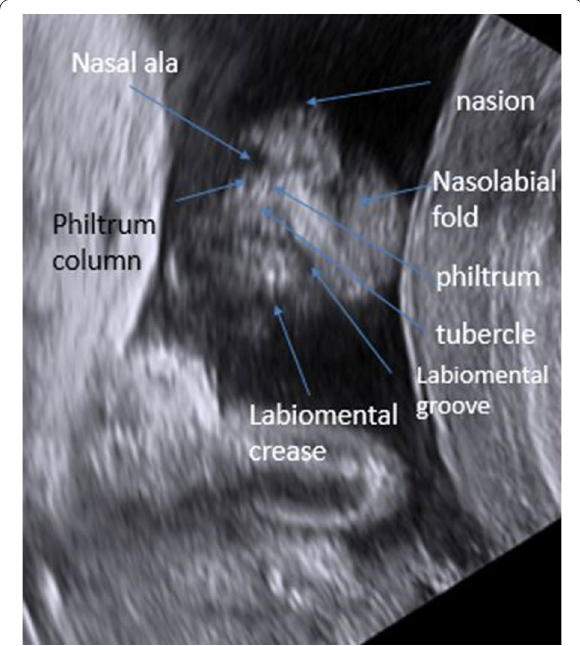
Fig. 1 Anatomy of the face; detailed nasolabial external anatomical landmarks